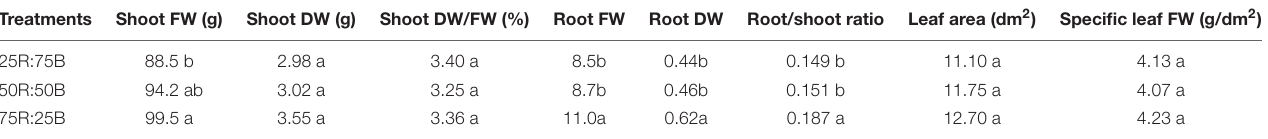
TABLE 2 | The shoot fresh weight (FW), shoot dry weight (DW), shoot DW/FW, root/shoot ratio, leaf area, and specific leaf FW of lettuce plants grown under continuous light (200 µ mol · m − 2 · s − 1 ) with different red:blue ratios.